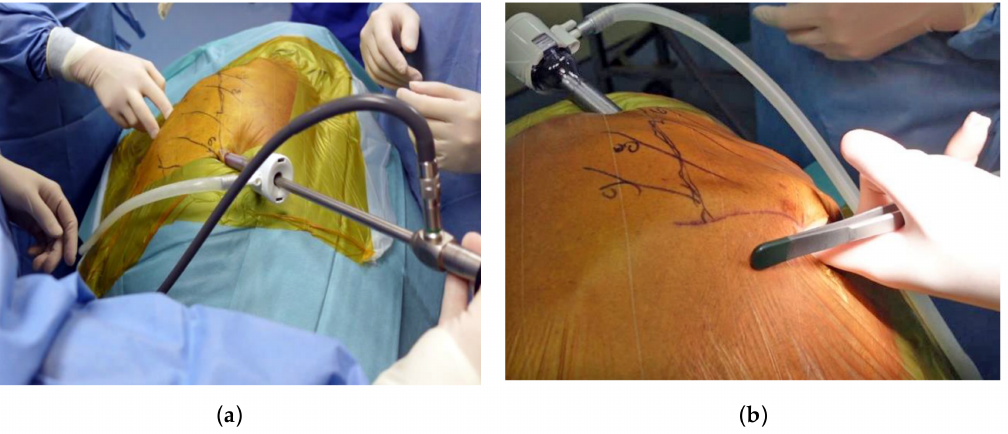
Figure 2. Subcostal anatomical lung resection performed by means of the da Vinci ® SP system. ( a ) An intercostal observation port was created in the sixth intercostal space along the middle-axillary line; ( b ) a 4 cm incision was initially made along the mid-clavicular line immediately below the subcostal margin, followed by the creation of a tunnel via finger blunt dissection under thoracoscopic